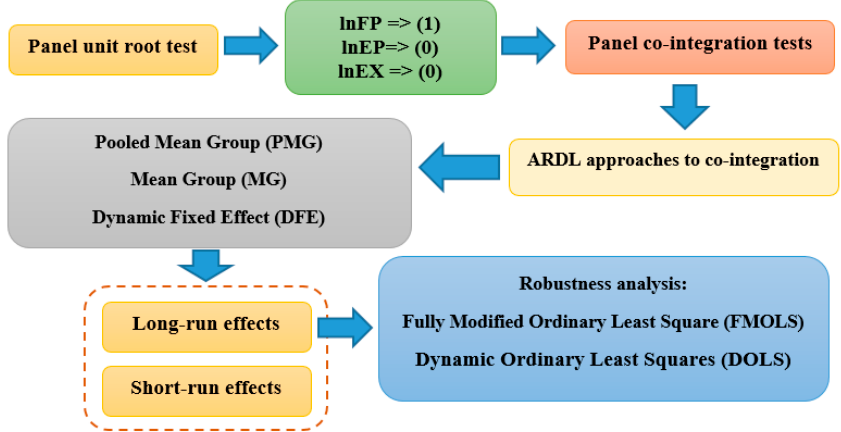
Figure 1. Flowchart of research methodology.